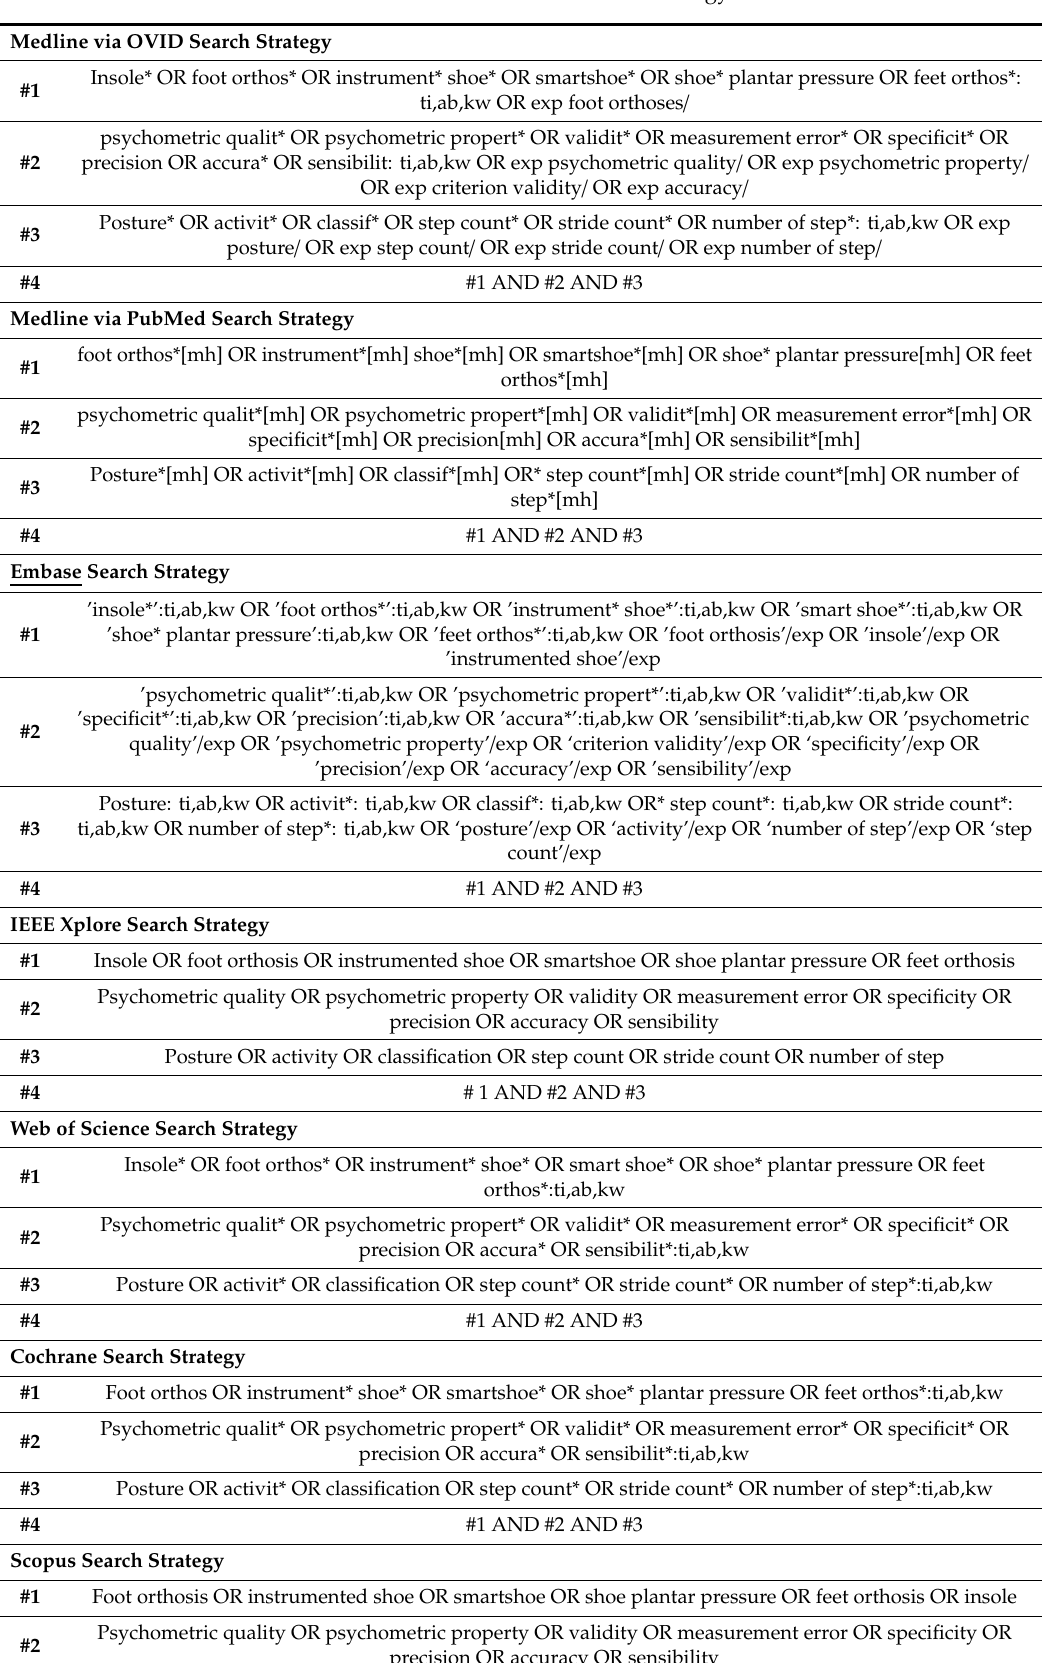
Table 1. Detailed literature search